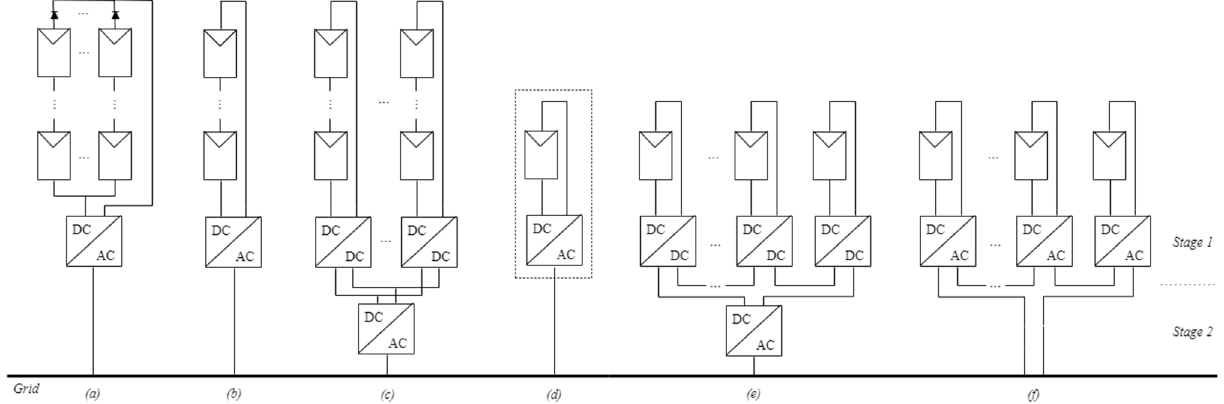
Figure 1. Power plants for grid connection: ( a ) central inverter; ( b ) string inverter; ( c ) multistring inverter; ( d ) ac-module inverter; ( e ) cascaded dc/dc converter; ( f ) cascaded dc/ac inverter.